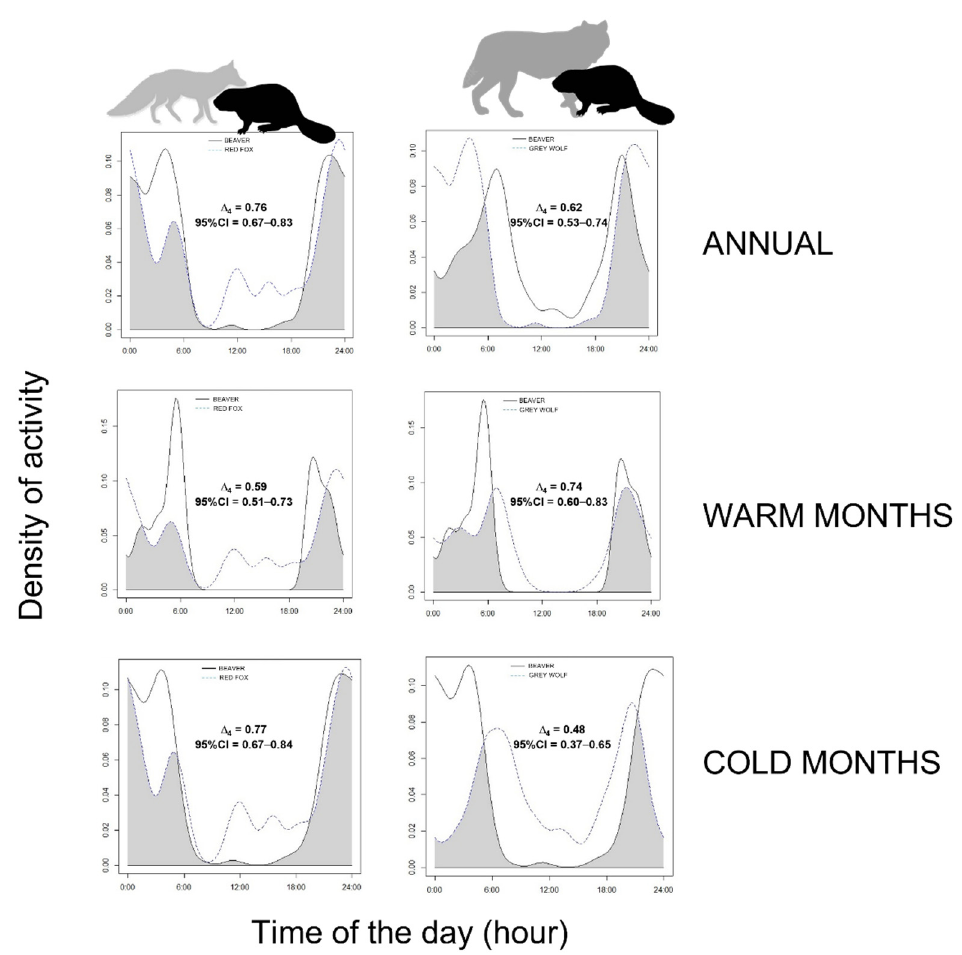
Figure 4. Interspecific overlap of activity patterns expressed as kernel density estimates (coefficient Δ 4 ) between the Eurasian beaver and its main potential predators ( left , red fox; right , grey wolf) in Central Italy; 95% CI = 95% Confidence Intervals.